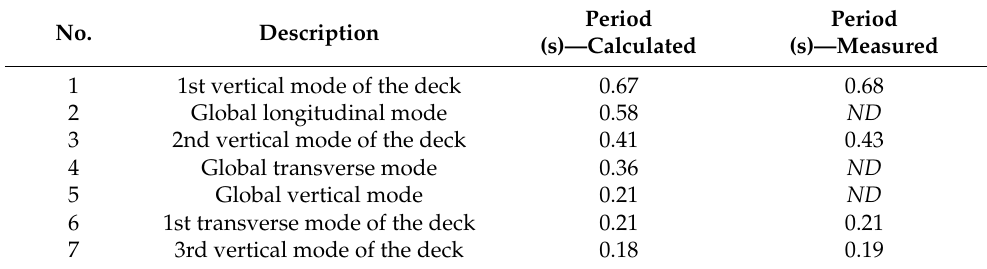
Table 5. Comparison of the calculated and measured modal